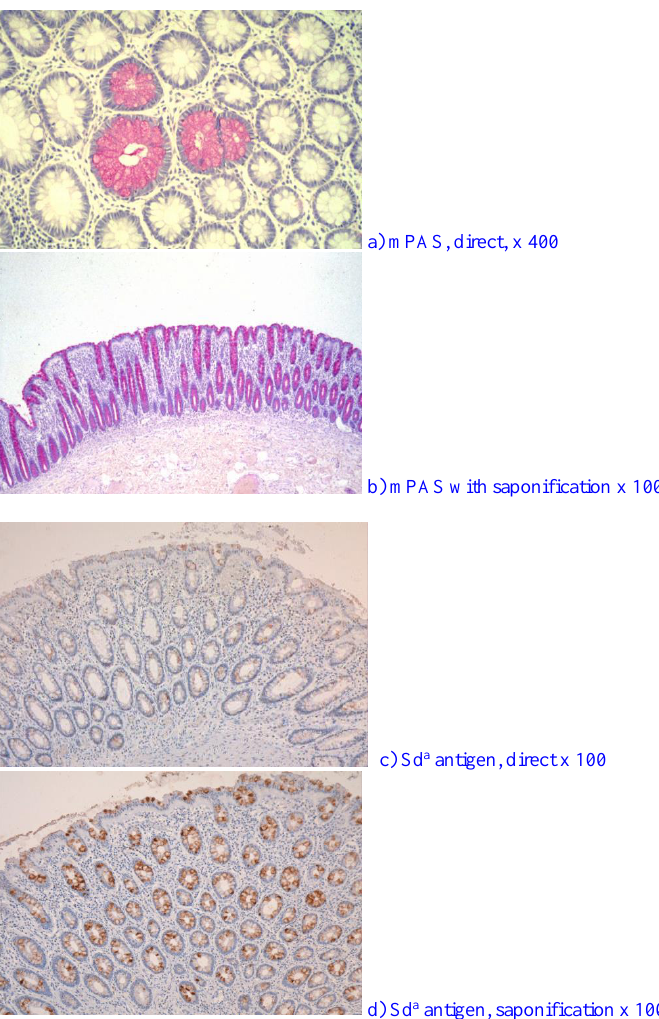
Figure 3. Histological Detection of O -acetylated Sialic acids and Sd a antigen. The O -acetylated sialic acids detected by the mPAS stain, directly ( a ) and with saponification, ( b ) this shows a longitudinal section of the mucosa, in contrast to a, c, and d. Also note the difference in magnification. Direct staining for the Sd a antigen with the KM694 antibody ( c ), and with saponification ( d ) is shown.